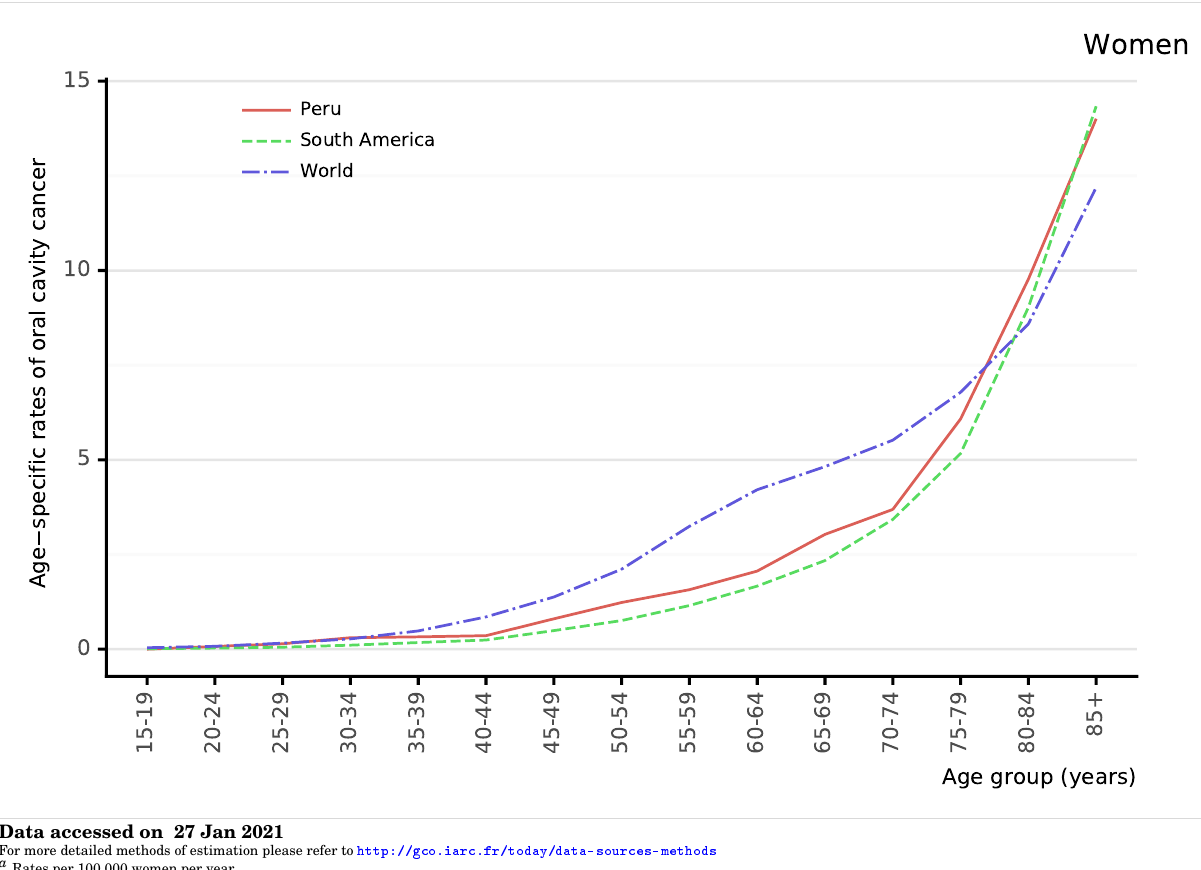
Figure 131: Comparison of age-specific oral cavity cancer mortality rates among women by age in Peru, within the region, and the rest of